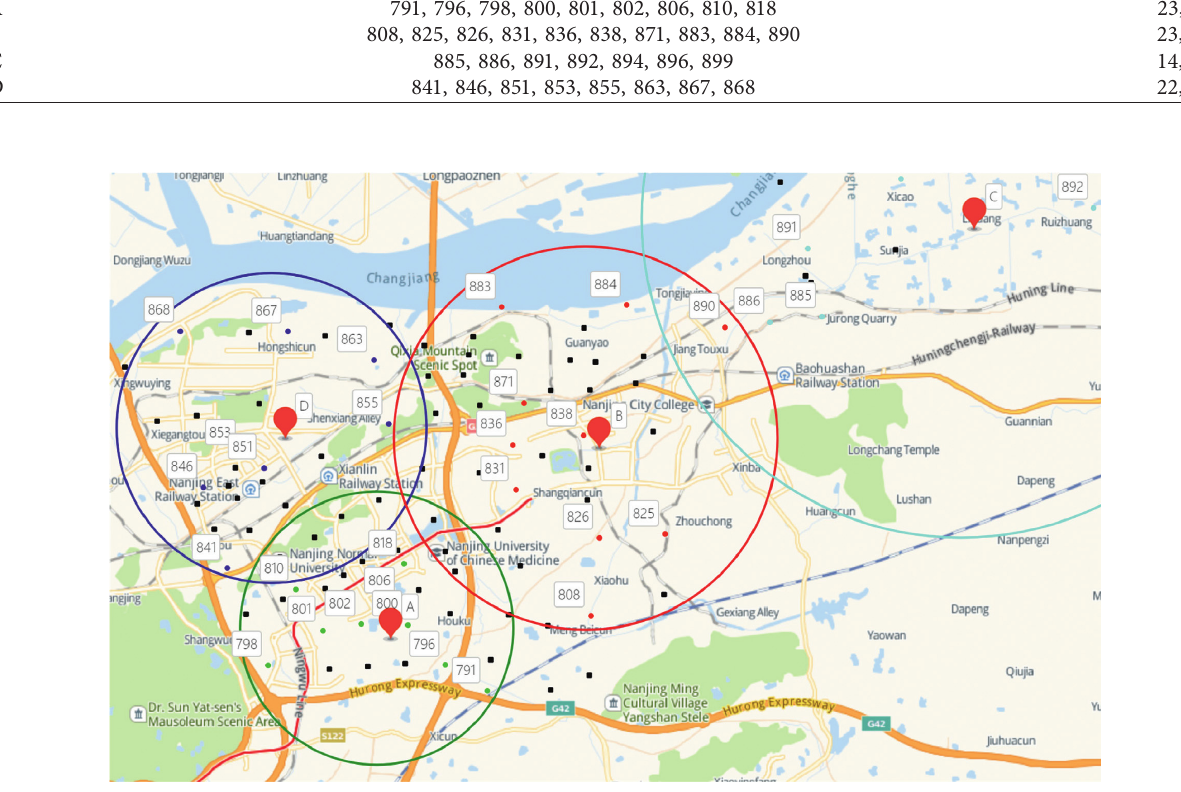
Figure 7: Distribution of the four PHs obtained using the ISODATA.